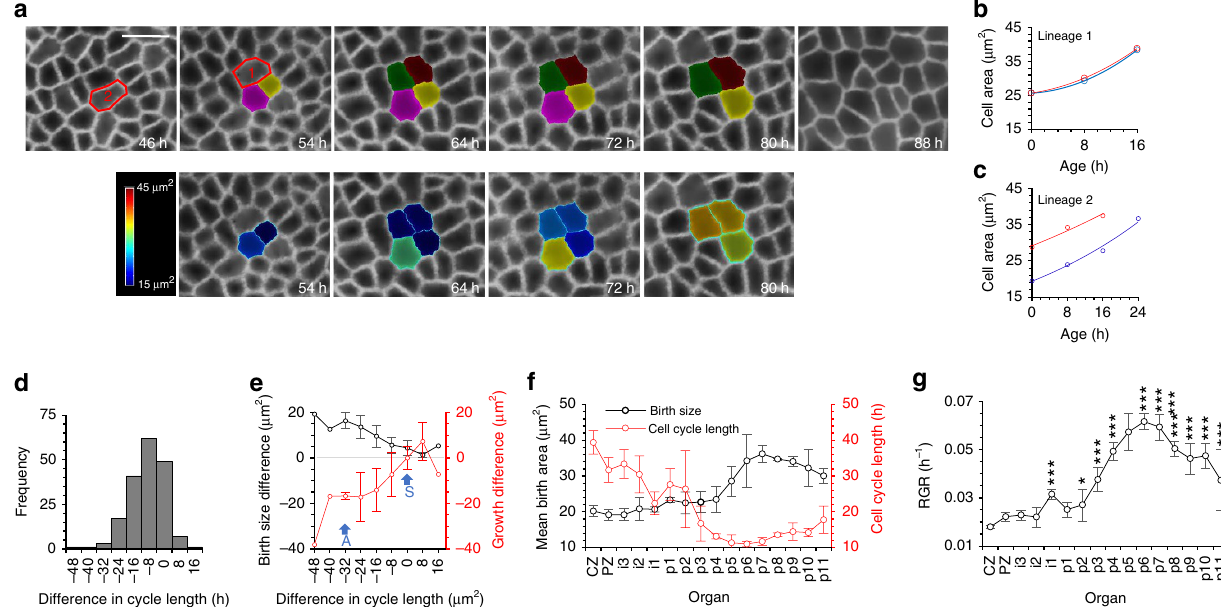
Figure 2 | An inverse relationship between cell size and cell cycle length and a positive relationship between RGR and cell size regulate cell size in the SAM and developing primordia ( a ) Time course images showing two example lineages (labelled 1 and 2) where both daughters of a division can be tracked through an entire cycle. Colours indicate cell identities (upper row) and outer cell surface area (lower row). Lineage 1 shows equal division of the parent cell. Lineage 2 shows unequal division of the parent cell. Scale bar represents 10 m m. ( b , c ) Cell sizes over time of daughters of lineages 1 and 2, which divide synchronously and asynchronously respectively. The daughter with the largest birth size is shown in red and the daughter with the smaller birth size is shown in blue. ( d ) Frequency distribution of differences in cell cycle length between daughter cells from the same division, calculated as the cycle length of the largest daughter at birth minus the cycle length of the smallest daughter at birth. n ¼ 182. ( e ) Mean difference in size at birth (black), calculated as area of larger daughter at birth—area smaller daughter at birth, and mean difference in total growth (red) calculated as increase in area of larger daughter at birth minus the increase in area of smaller daughter at birth. Negative growth difference values indicate that the smaller daughter grew by the largest amount. Data grouped by difference in cell cycle length ( n varies by group, n ¼ 1, 1, 3, 17, 41, 62, 49, 7, 1). Synchronously (S) dividing sisters show little difference in size at birth or in growth, but asynchronously dividing sister cells (A) show larger differences in size at birth and undergo different amounts of growth. Error bars represent s.d. ( f ) Mean cell size at birth and mean cell cycle length of cells grouped by developmental zones where CZ ¼ central zone, PZ ¼ peripheral zone, i ¼ incipient primordia and P ¼ primordia. Means calculated from three stems. Error bars represent s.d. ( g ) Mean relative growth rate (RGR) of cells grouped by developmental zones as described above. Means calculated from three stems. Error bars represent s.d. Note that there is greater variation between cells in different zones than between cells in the same zones (One-way ANOVA, F(15,1) ¼ 29.989, P o 0.001). *, **, *** indicate significant difference from the RGR of the CZ at the 0.05, 0.01 and 0.001 levels